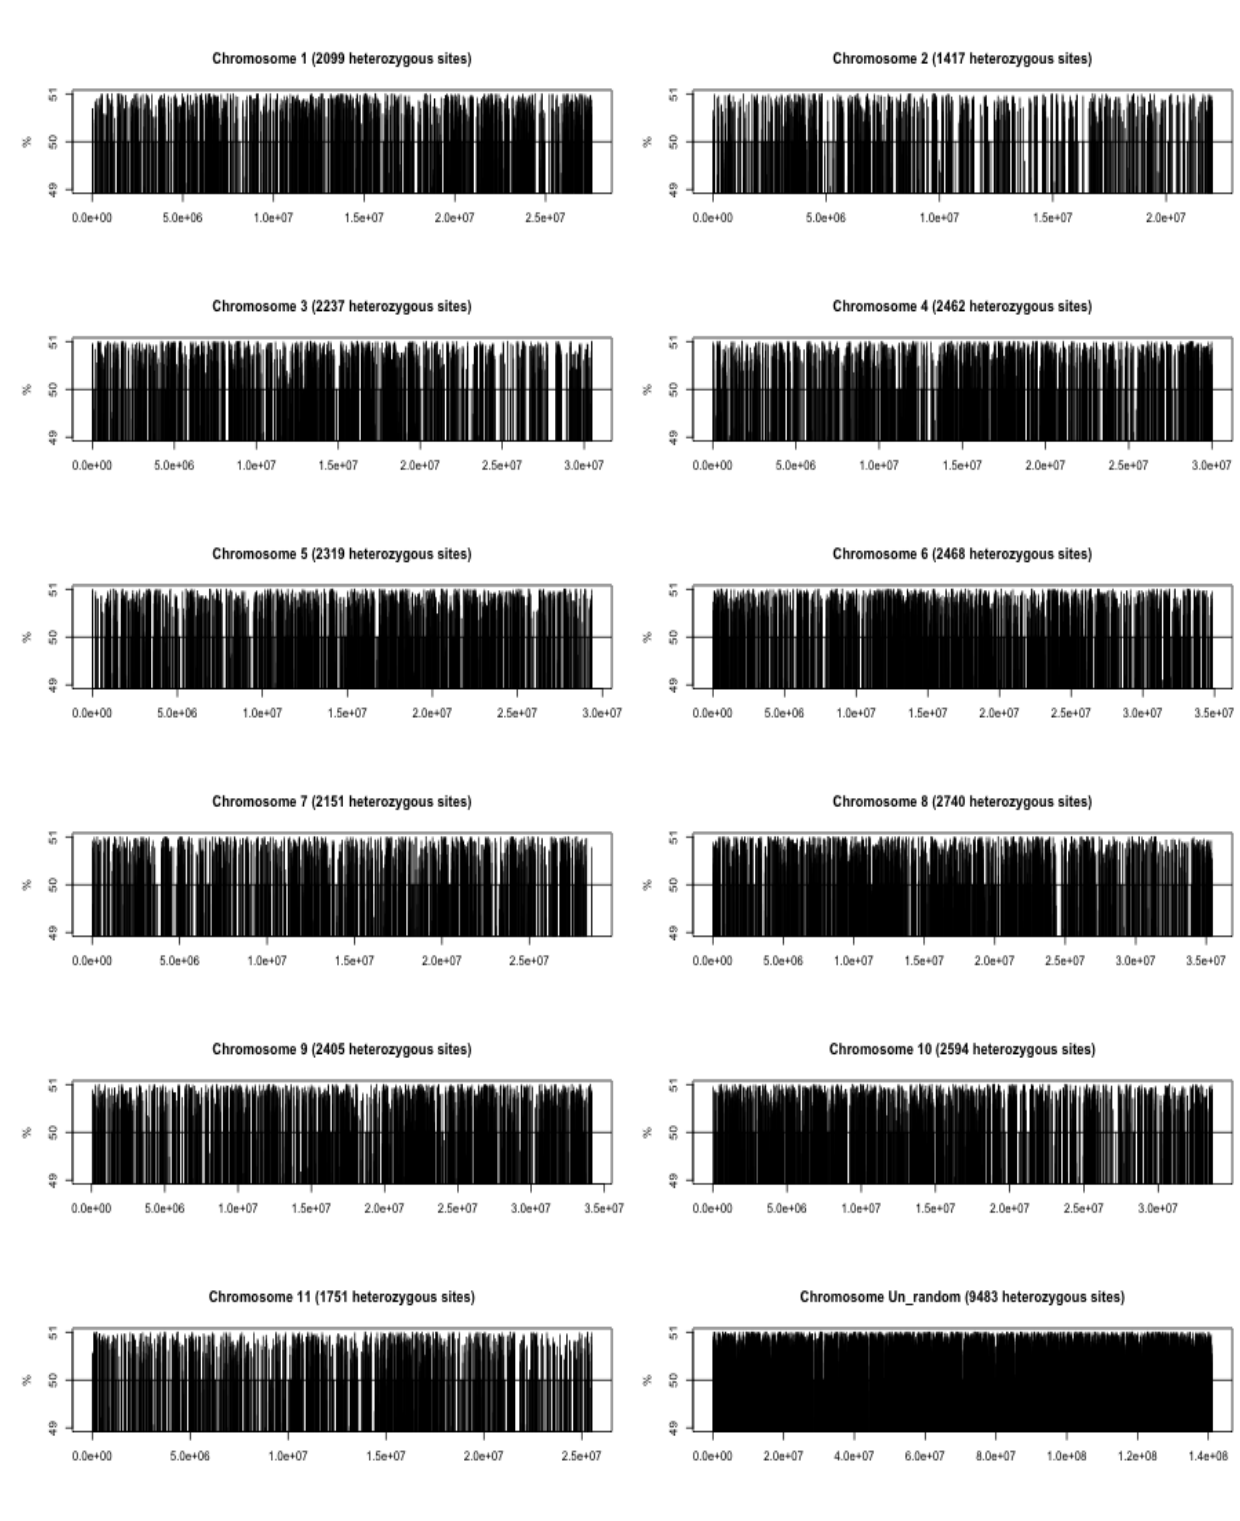
Figure 2. Positions on the banana genome that display heterozygosity in enset. The horizontal axis indicates position on the chromosome and the vertical axis indicates the frequency of the most common base (A, C, G, or T). Only those sites are shown at which there is at least 10× coverage and at which the frequency of the most abundant base is between 49% and 51%